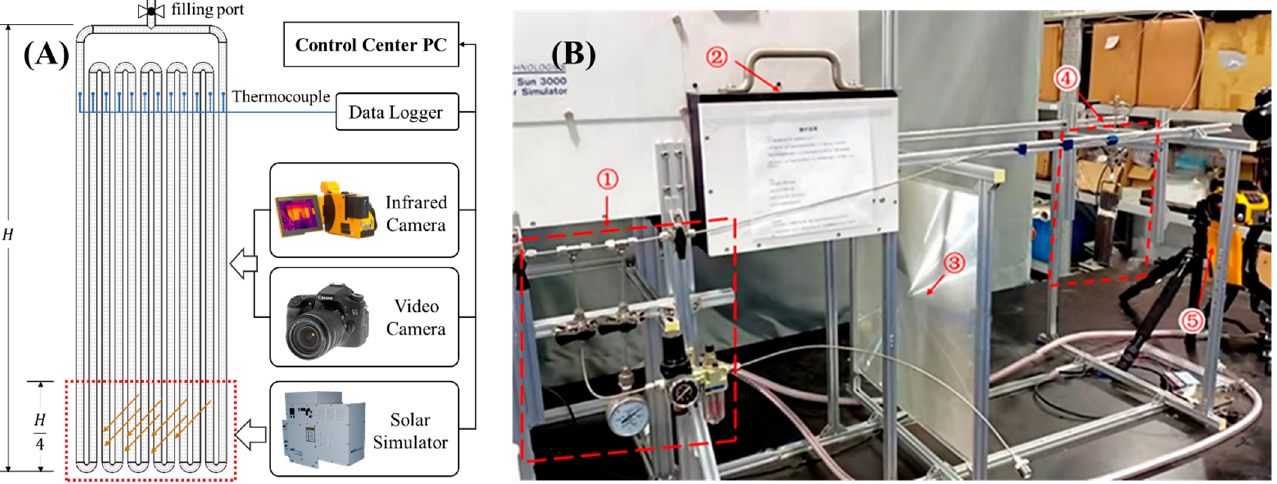
Figure 4. ( A ) Experimental schematic of solar nanofluid pulsating heat pipe experiment; ( B ) pho- tograph of solar nanofluid pulsating heat pipe experiment: 1. filling system; 2. solar simulator; 3. Fresnel lens; 4. PHP; 5. infrared camera and video camera.